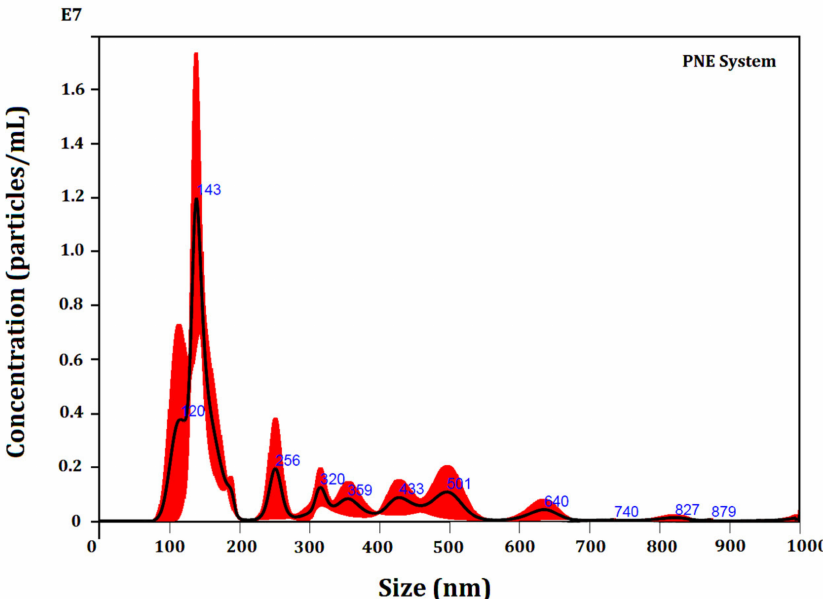
Figure 4. NTA particle size distribution analysis of the biodefensive PNE. Representative histogram of the average size distribution (black line) from three measurements of a single sample. Red areas specify the standard deviation (SD) between measurements, and blue numbers indicate the maxima of individual peaks.